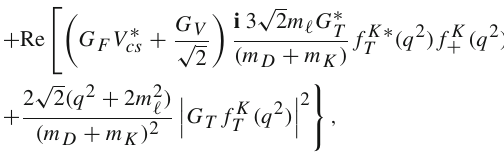
toquark S 0 is analyzed here. S 0 transforms as